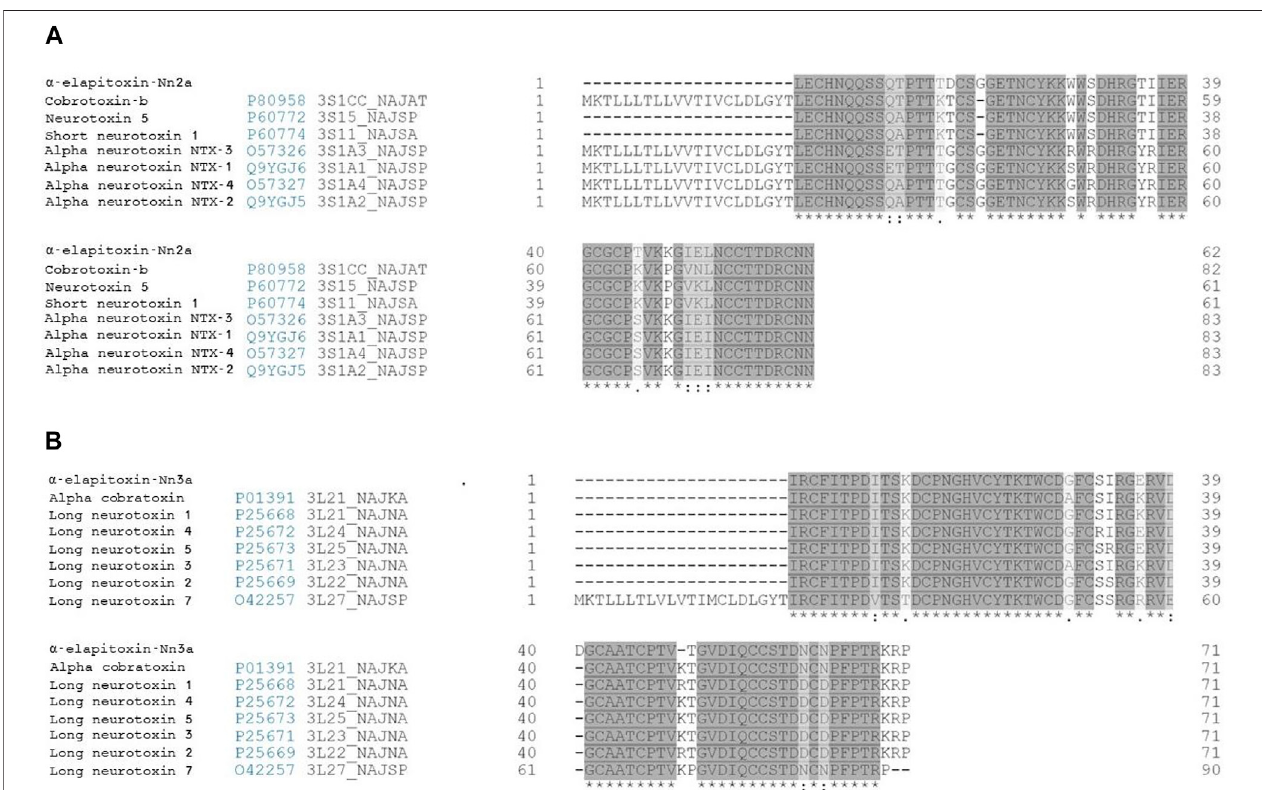
FIGURE 4 | Sequence alignment (from BLAST search) of (A) α -Elapitoxin-Nn2a with short-chain α -neurotoxins and (B) α -Elapitoxin-Nn3a with long-chain α - neurotoxinsfrom N. naja venom.Amino acidswith (*)are fully conserved in alltoxins,conservedaminoacidswith (.)are weakly similar properties group and amino acids with (:) are strongly similar properties